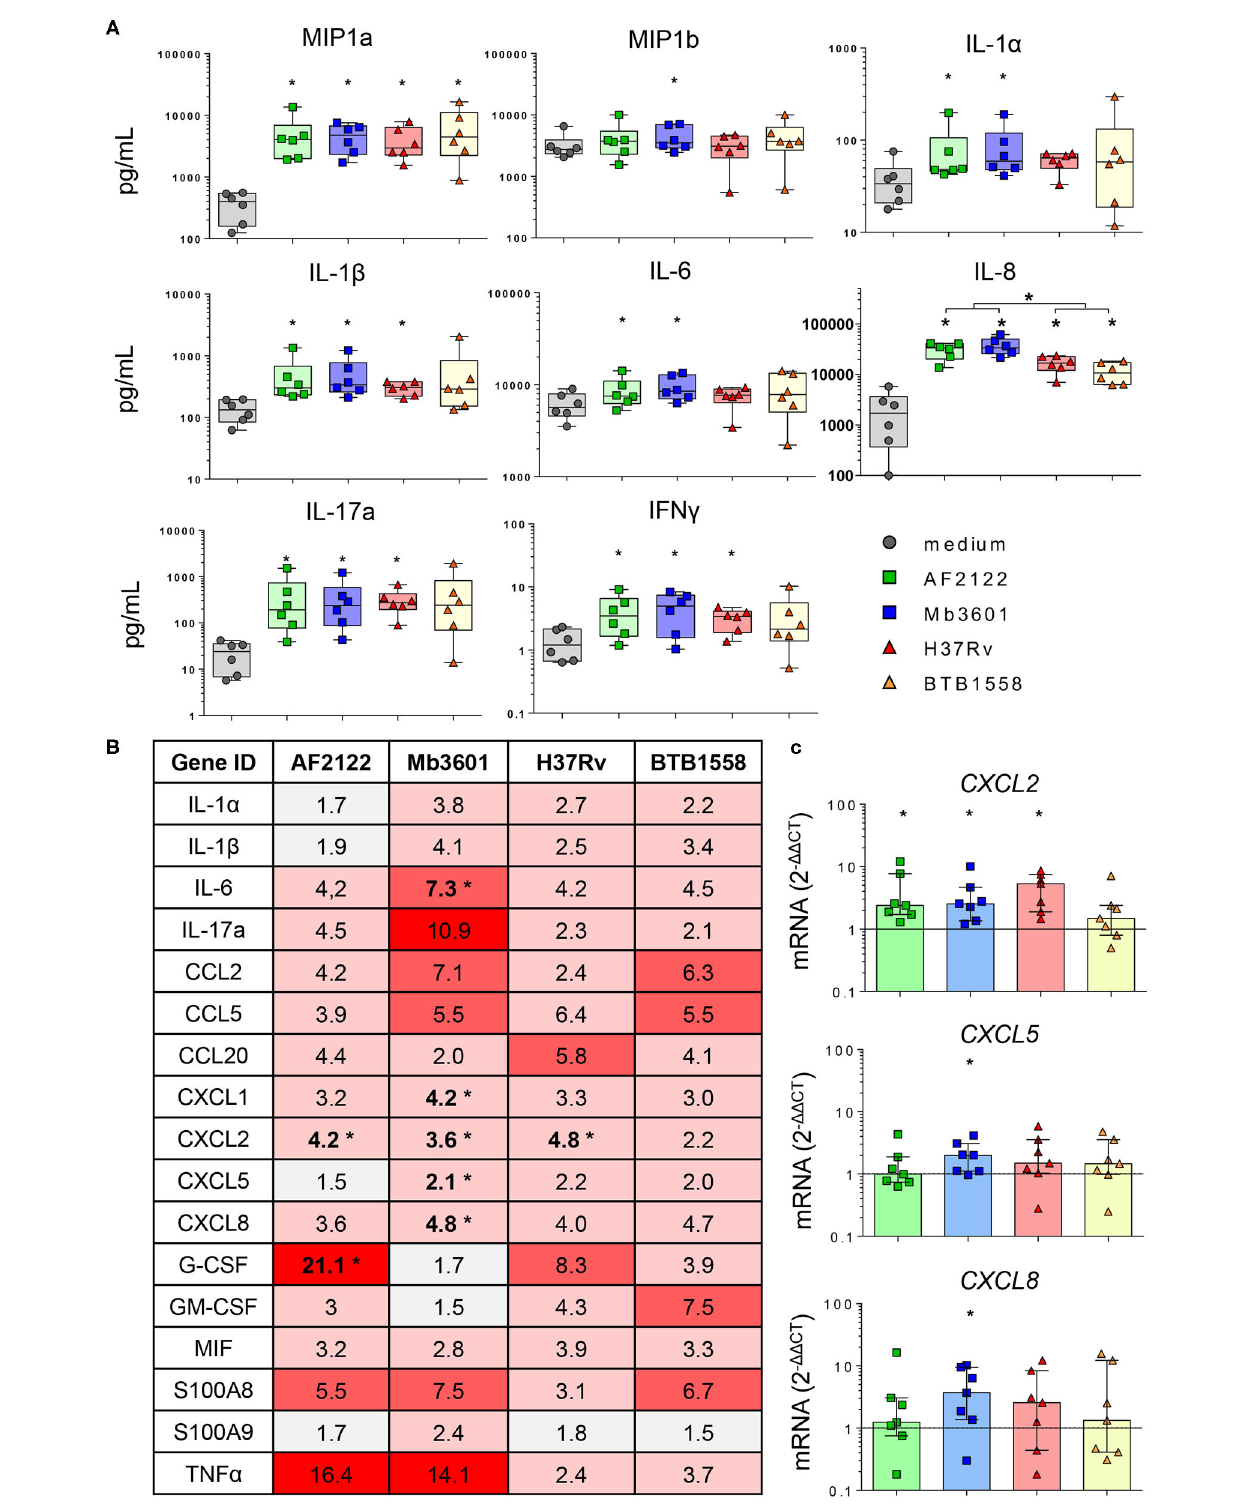
FIGURE 4 | The lung inflammatory neutrophil and monocyte recruitment signature induced by infection in precision-cut lung slice (PCLS) from Blonde d’Aquitaine cows is more efficiently triggered by Mycobacterium bovis than Mycobacterium tuberculosis . (A) The cytokine and chemokine levels were measured in